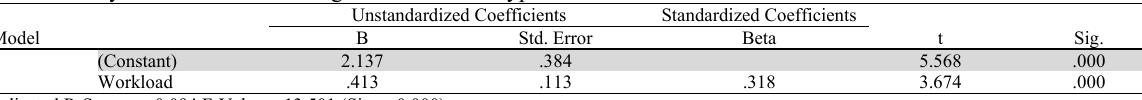
The summary of the results of testing the second sub-hypothesis